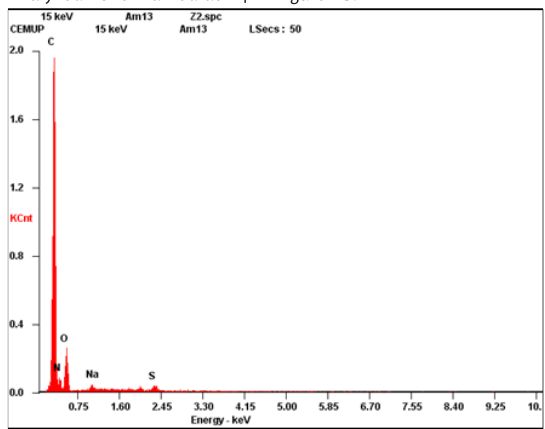
Figure 2C. X-Ray Microanalysis (XRM) Spectrum Showing the Pre- sence of Copper (Cu) and Zinc (Zn) in Renal Tumor Tissue in the Analyzed Zone Marked as Z4 in Figure